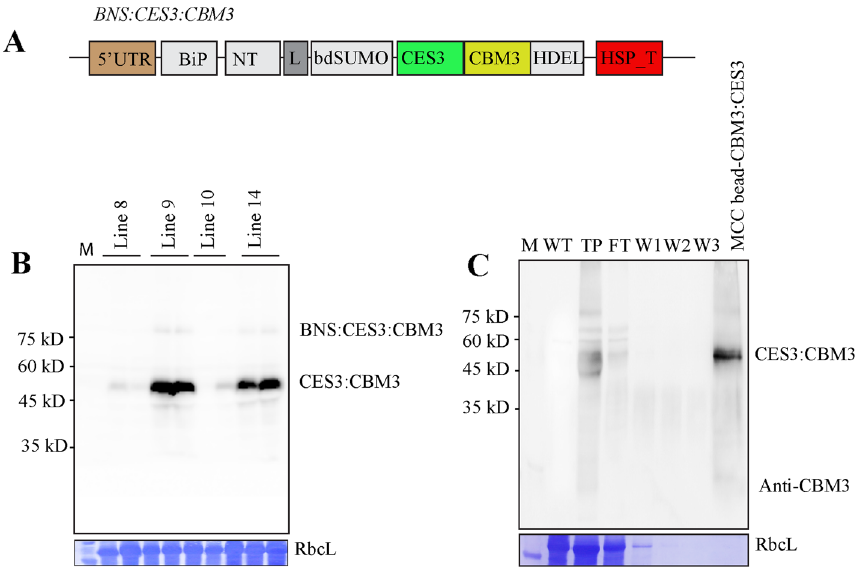
Figure 5. Expression of CES3-containing recombinant proteins in transgenic Arabidopsis plants and immobilisation of processed CES3:CBM3 onto MCC beads. ( A ) Expression of BNS:CES3:CBM3 in transgenic Arabidopsis plants. Total protein extracts were prepared from homozygous plants of the T3 generation and analysed by western blotting using an anti-CBM3 antibody. The number on the top indicates independent lines. ( B ) Immobilisation of processed CES3:CBM3 onto MCC beads. Transgenic Arabidopsis plants expressing BNS:CES3:CBM3 were grown under endotoxin-free conditions. Total protein extracts were prepared and mixed with MCC beads that had been washed and suspended in endotoxin-free water. The mixture was incubated at room temperature for 2 h, and MCC beads were extensively washed to remove unbound proteins. The samples were collected at every step during immobilisation. Proteins were separated by SDS-PAGE and analysed by western blotting using an anti-CBM3 antibody. M, size standard; WT, non-transgenic plants; TP, total